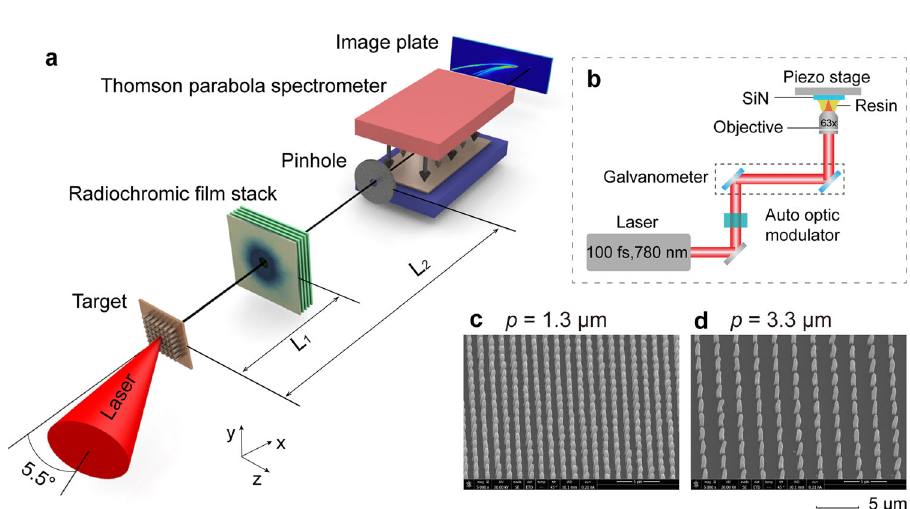
Fig. 1 Experimental arrangement and preparation of microwire array (MWA) targets. a Sketch of the experimental setup. b Schematic diagram of laser direct writing that prepares the MWA structure: the laser pulses with wavelength of 780 nm and duration of 100 fs are controlled via the galvanometer system to scan space voxel in the photoresin after the objective lens and the laser pulse energy is modulated by the acousto optic modulator. c , d Show the scanning electron microscope images of MWA with periods of 1.3 and 3.3 μ m,